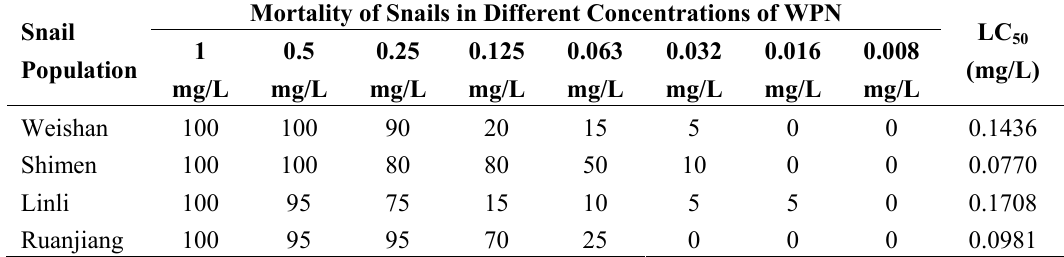
Table 2. Comparison of mortality rates and LC sampled from different regions of China following immersion in various concentrations of WPN for 24